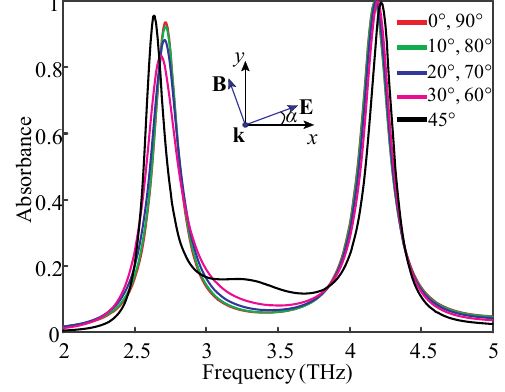
Fig. 7 Absorbance for different polarization angles of α = 0° – 90°. Inside the figure, the angle α is